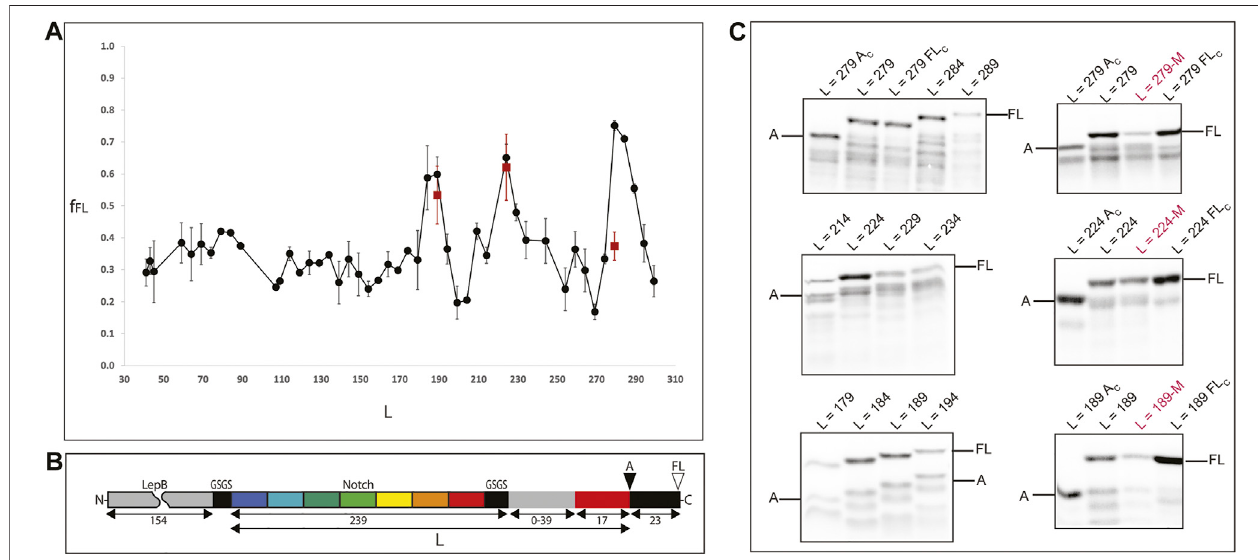
FIGURE 3 | Experimental determination of protein folding on the ribosome. (A) Force pro fi le generated by the full protein and a set of C-terminal truncations of the Ankyrin Notch. Shorter constructs have C-terminal deletions in the Ankyrin domain (keeping a constant linker) and longer constructs have linker segments of 0 – 39 residues (gray rectangle in panel B). All points are at least two independent measurements; averages ±SE are shown. A double mutation (A125E/A126F) known to disruptfoldingforthefullproteinwasintroducedatthepeakconstructs(redsquares). (B) Theforce-generatingankyrindomain(andC-terminaltruncationsthereof; repeatsindicatedincolors)isconnected,viaavariable-lengthlinker(gray)andan “ insulating ” SGSGtetrapeptide(black),tothe17-residueSecMAP(red). AnN-terminal 154-residue segment from the E. coli LepB protein (gray) and a short GSGS segment (black) is included in short constructs (length L ≤ 110, where L is the number of residues between the N-terminal end of the Ankyrin part and the last residue in the AP) in order to make short Ankyrin constructs conveniently amenable to analysis by SDS-PAGE, and a 23-residue C-terminal tail (also from LepB) is appended at the C terminus in order to make it possible to separate arrested (A) and full-length (FL) chains by SDS-PAGE. The sequences of all constructs are included in Supplementary Table S1 . (C) SDS-PAGE images of measurements around peak constructs andfoldingdisruptingmutations.Left:gelsshowingexpressionofconstructsaroundthe f FL peaks[L=279,L=224,L189].Thetoppanelleftshowstwocontrolsaround theL=279measurement:L=279Ac(sameconstructwithastopcodonatpositionP17inthearrestpeptide)andL=279Fc(inactivatedarrestpeptideP17Amutation) to identify the bands to be integrated during the measurements. Right: measurements of mutations M (A125E/A126F) at the peak constructs (indicated in red) also fl anked by